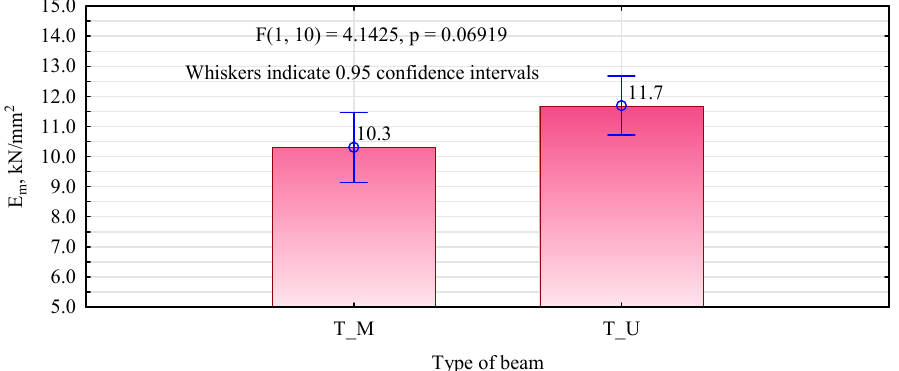
Figure 16. Statistical analysis of the modulus of elasticity of the manufactured 6-layer beams.